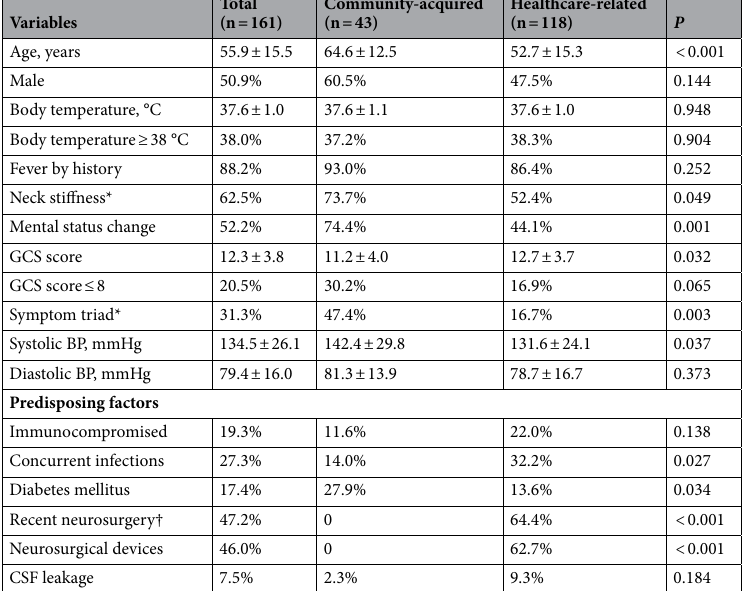
Table 1. Clinical features of bacterial meningitis at presentation. Data are presented as mean ± SD or %. *Data were available in 85 cases. †Recent neurosurgery refers to neurosurgery within 1 month of the onset of meningitis. Abbreviations: GCS, Glasgow coma scale; CSF, cerebrospinal fluid.